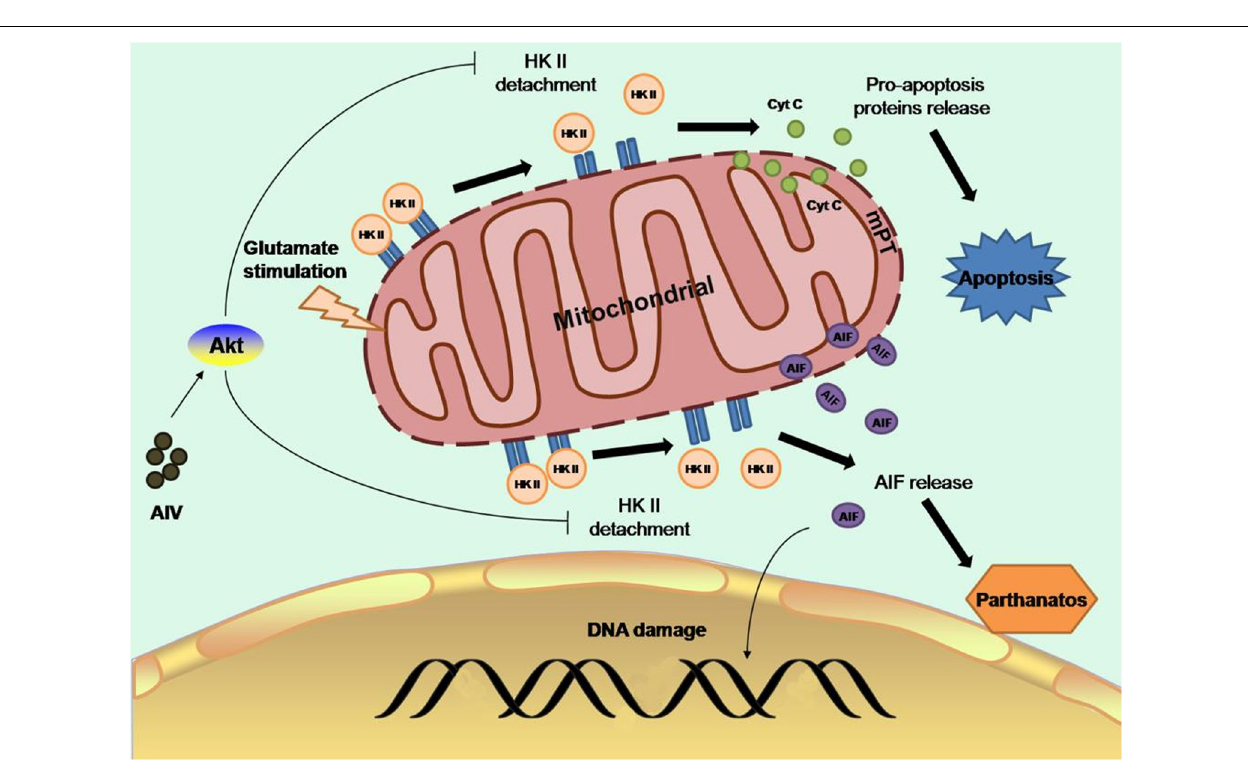
FIGURE 2 | Astragaloside IV can preserve mitochondrial HK-II and subsequently protect neurons from apoptosis and cell death by promoting the binding of Akt to HK-II, which activates Akt and protects mitochondrial HK-II, improving glycolysis, and protecting hexokinase (Springer).